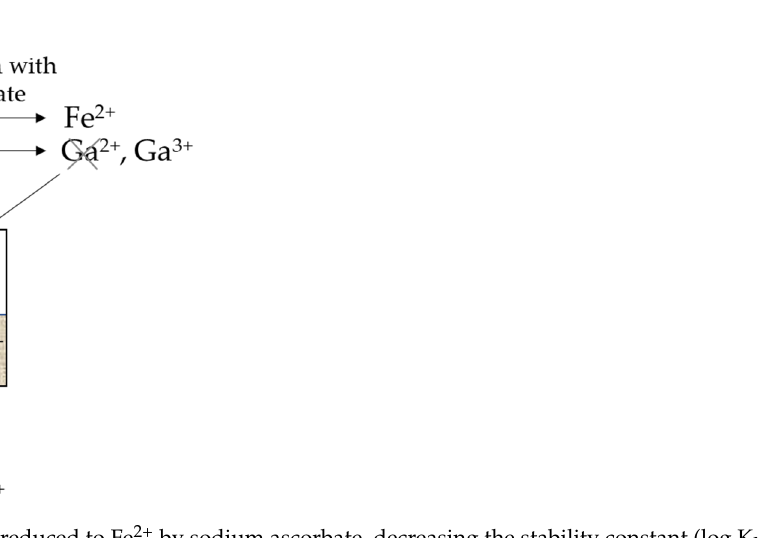
Figure 1. Fe 3+ is reduced to Fe 2+ by sodium ascorbate, decreasing the stability constant (log K ML ) to the UTEVA resin. Ga 3+ is not reduced by sodium ascorbate.